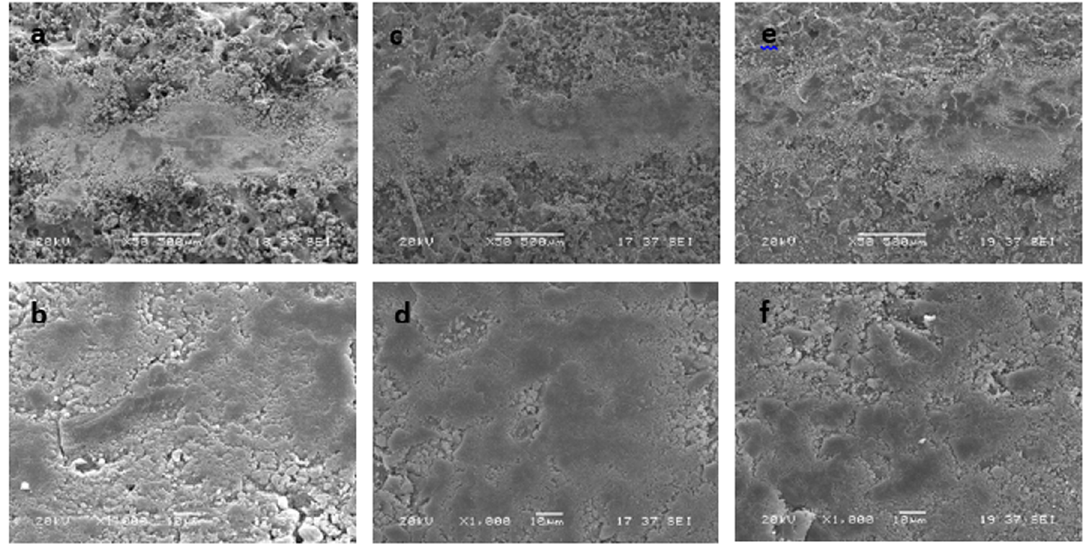
, (e-f) MAO-Al O 2 2